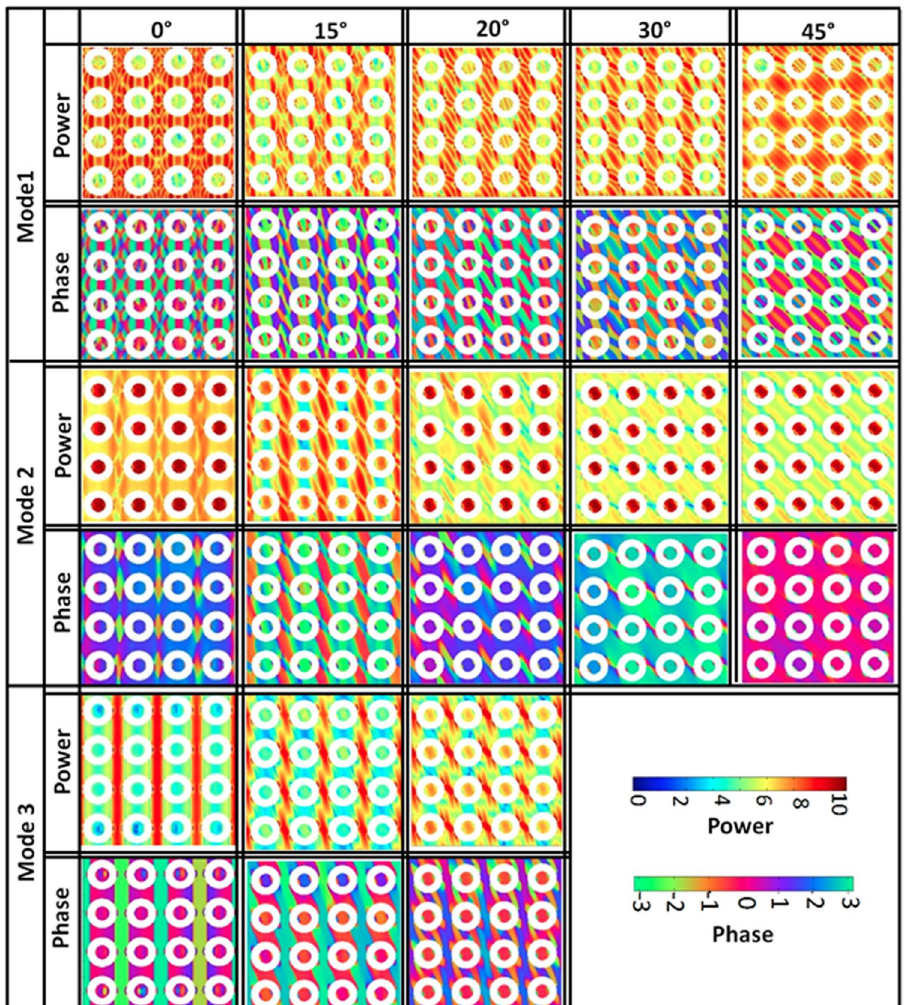
Figure 4. Spin-wave mode profile of the sample for different orientations of the in-plane bias magnetic field. The colour map used for the mode profiles is shown in the